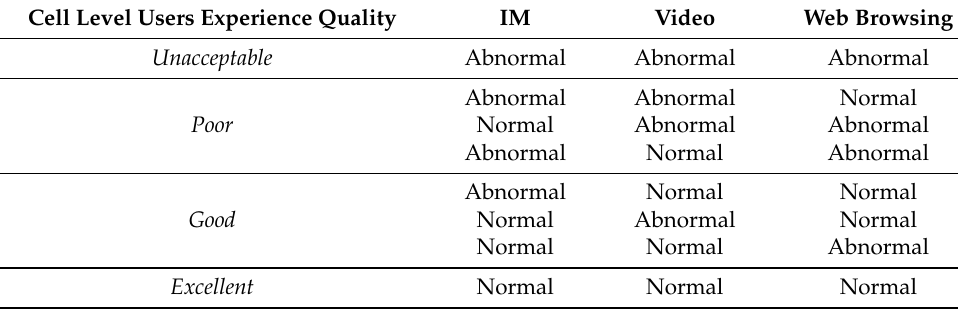
Table 4. Cellular network perception